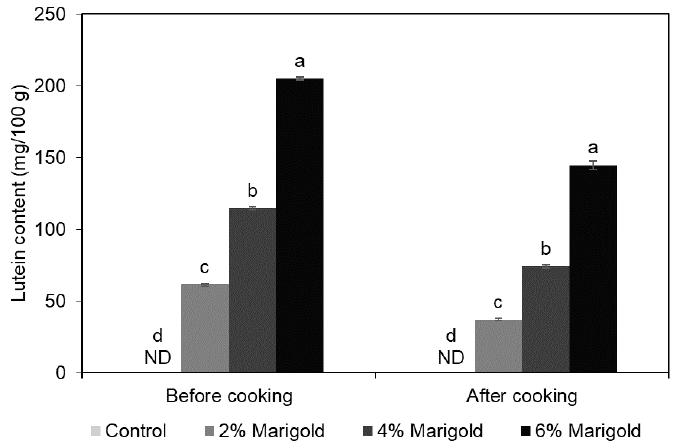
Figure 5. The lutein contents of the noodles prepared with marigold powder before and after cooking (ND: not detected, means with different letters on the bars differ significantly at p < 0.05).